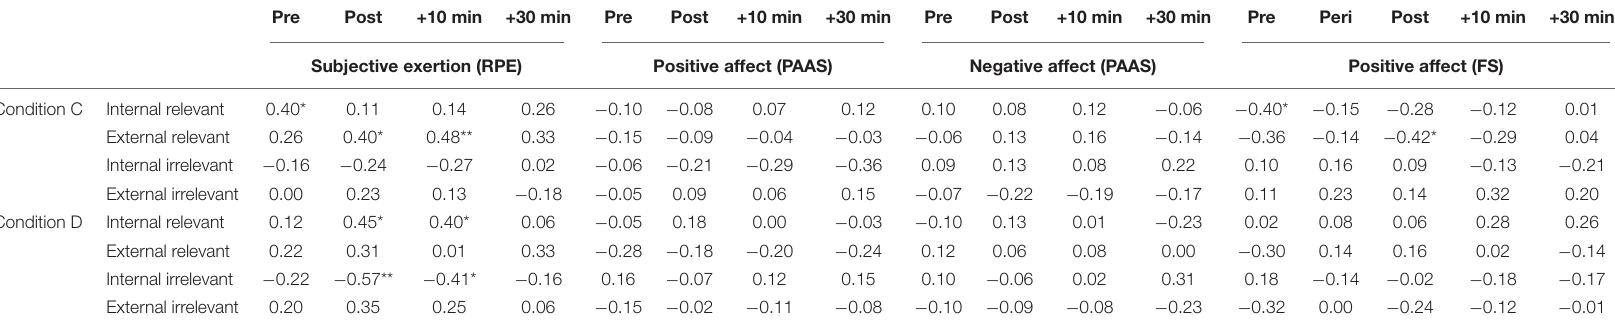
TABLE 3 | Pearson correlation coefficients for self-reported focus of attention and subjective exertion (RPE), positive affect (PAAS), negative affect (PAAS), and positive affect (Feeling Scale). Pre Post